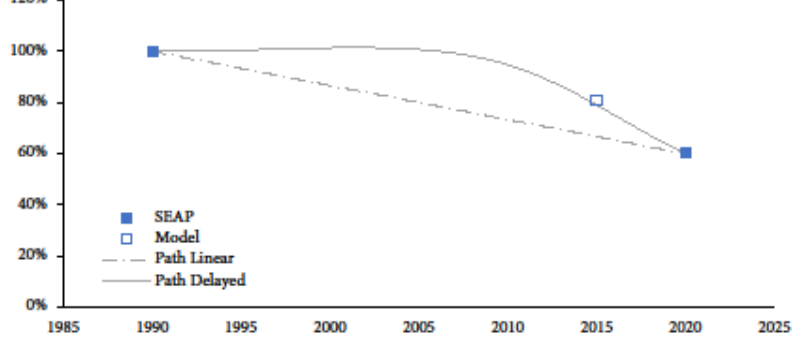
Figure 5. Projected reduction of local GHG emissions by 2020 as presented in the SEAP Malmö and the observed reduction in 2015 (compared to 1990 level), and two possible paths to achieve the desired reduction by 2020.